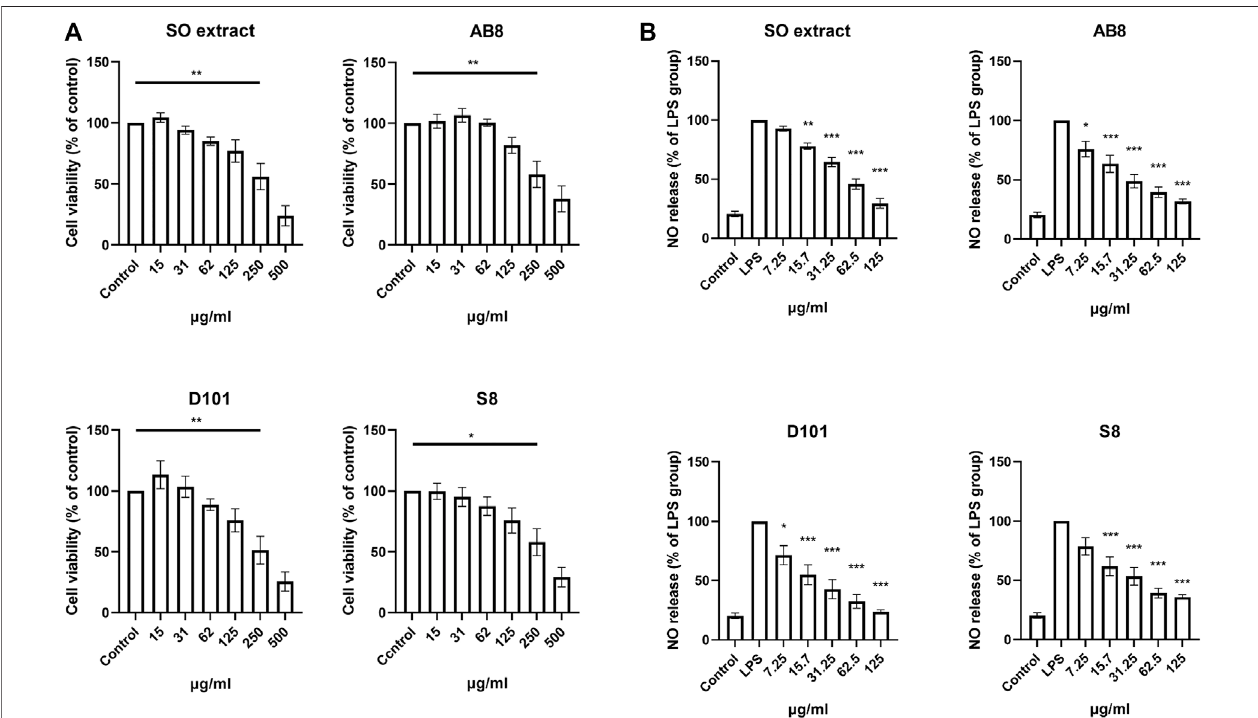
FIGURE 2 | Cell viability and anti-in fl ammatory effects of SO fractions in BV2 cultures. (A) BV2 cells were treated with SO extract and fractions at different concentrations for 24 h. Cell viability was measured by MTT assay. Signi fi cant toxic effect was considered when viability was below 75% compared to control. Data are presentedasthemean andSEM ( n =6). * p < 0.05, ** p < 0.01compared withthecontrolgroup. Values wereanalyzed byone-wayANOVA withTukey posthoc test. (B) Inhibition in a dose dependent manner of nitric oxide release was observed in LPS treated BV2 cultures treated with SO fractions for 24 h. Lowest IC 50 was observed in D101 treatment group (IC 50 = 37.32 μ g/ml). Data are presented as the mean and SEM ( n = 4). * p < 0.05, ** p < 0.01, *** p < 0.001 compared with the LPS group. Values were analyzed by one-way ANOVA with Tukey post hoc